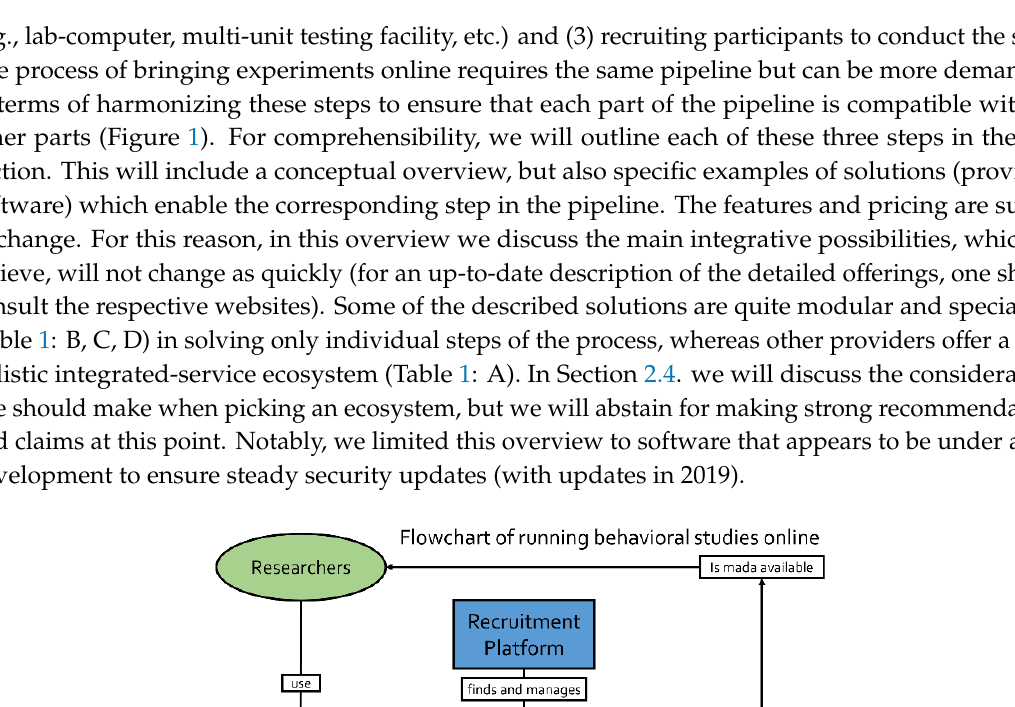
Figure 1. Schematic flow of conducting online experiments. First, experiments are created with an experiment builder. The compiled experimental files are then uploaded to an online host, which generates a link, making the study accessible online (potentially with the aid of a study management system). Participants are recruited through recruitment platforms and access the online experiments on the host. The data is stored on the hosting server.